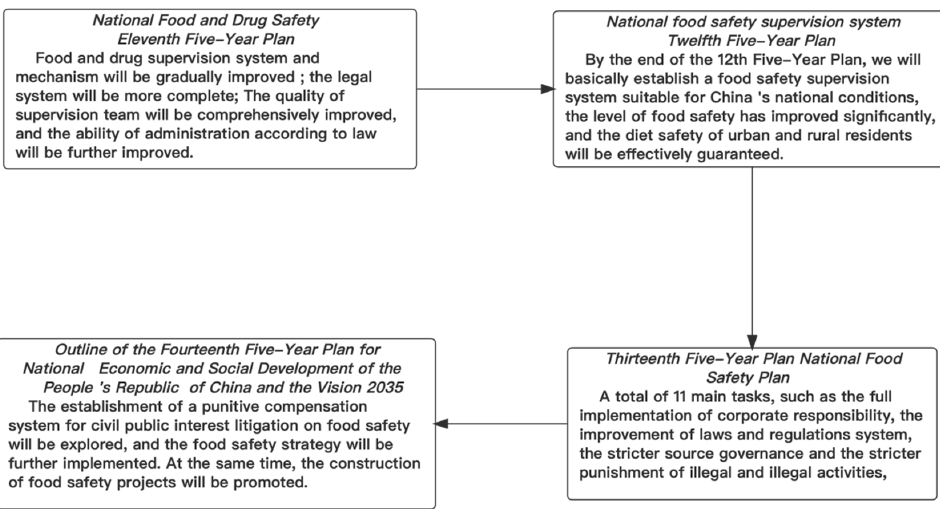
Figure 2. The Policy development process of the food safety